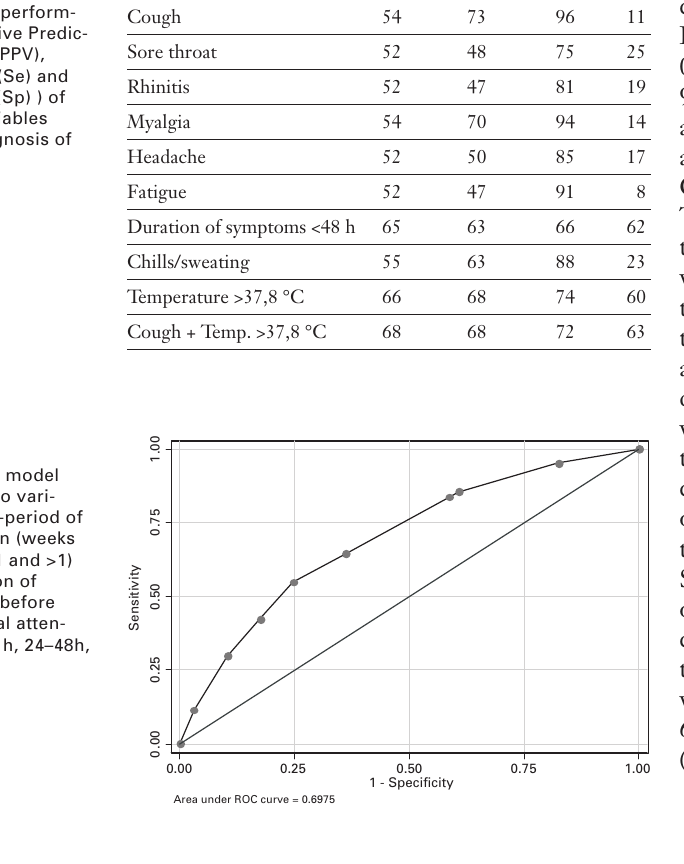
ROC curve, model with the four variables: time-period of consultation (weeks 49–50, 51–5), duration of symptoms before first medical attendance (<48h, >48h), continuous temperature and cough.